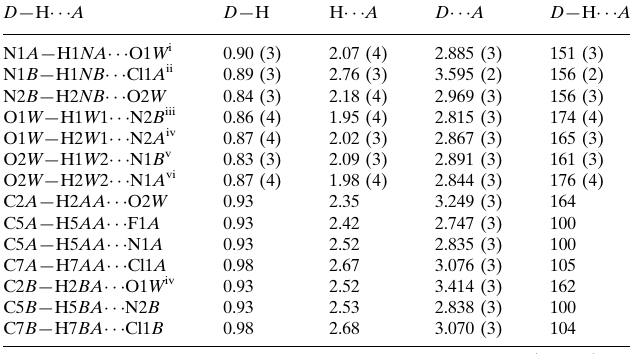
Hydrogen-bond geometry (A˚ , (cid:3) ). D —H (cid:1)(cid:1)(cid:1) A D